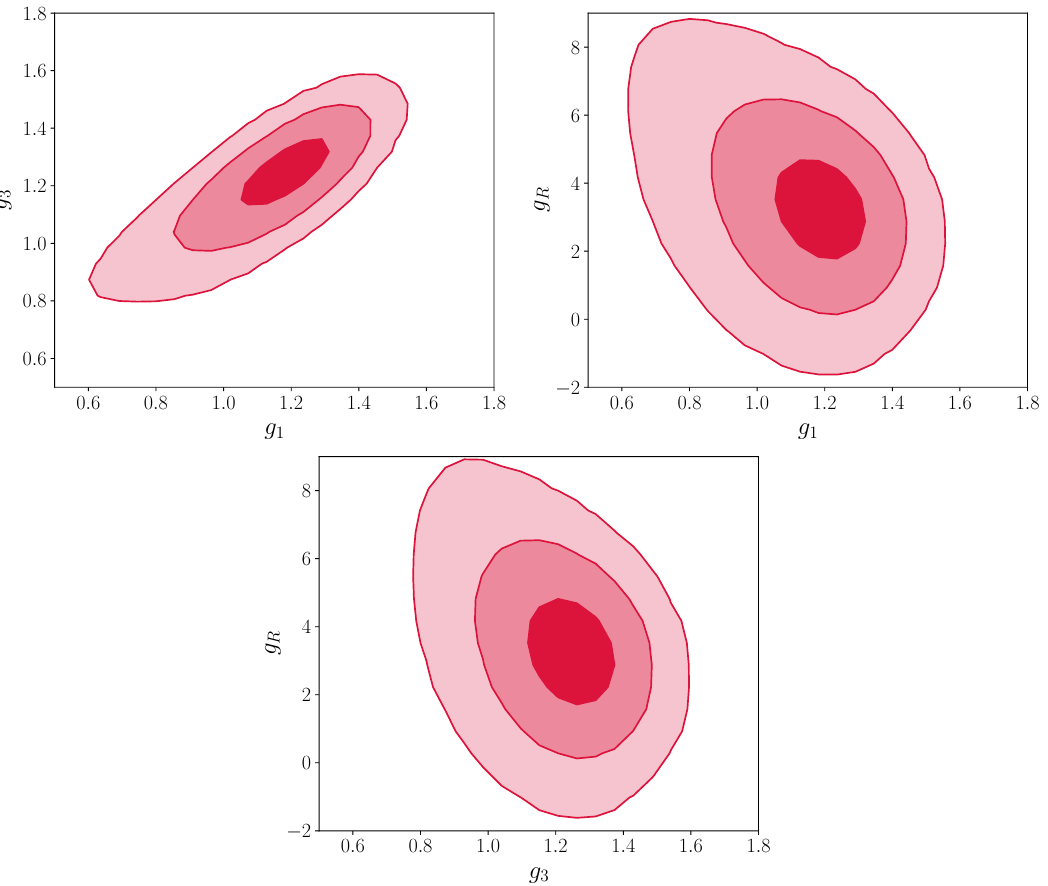
Figure 2 . Fit results for the parameters g 1 , g 3 and g R . The shaded areas, from darker to lighter red, describe the 1 , 2 and 3 σ regions,